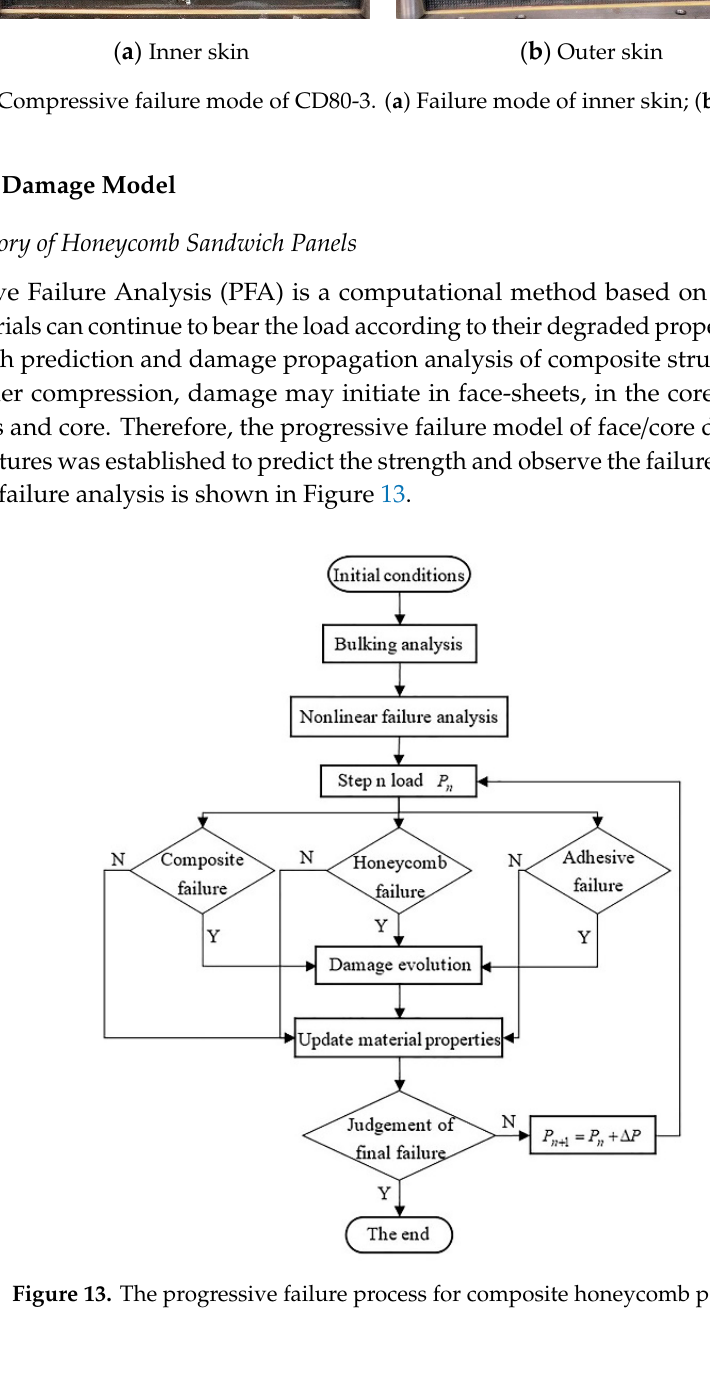
Figure 12. Compressive failure mode of CD80-3. ( a ) Failure mode of inner skin; ( b ) Failure mode of outer skin.